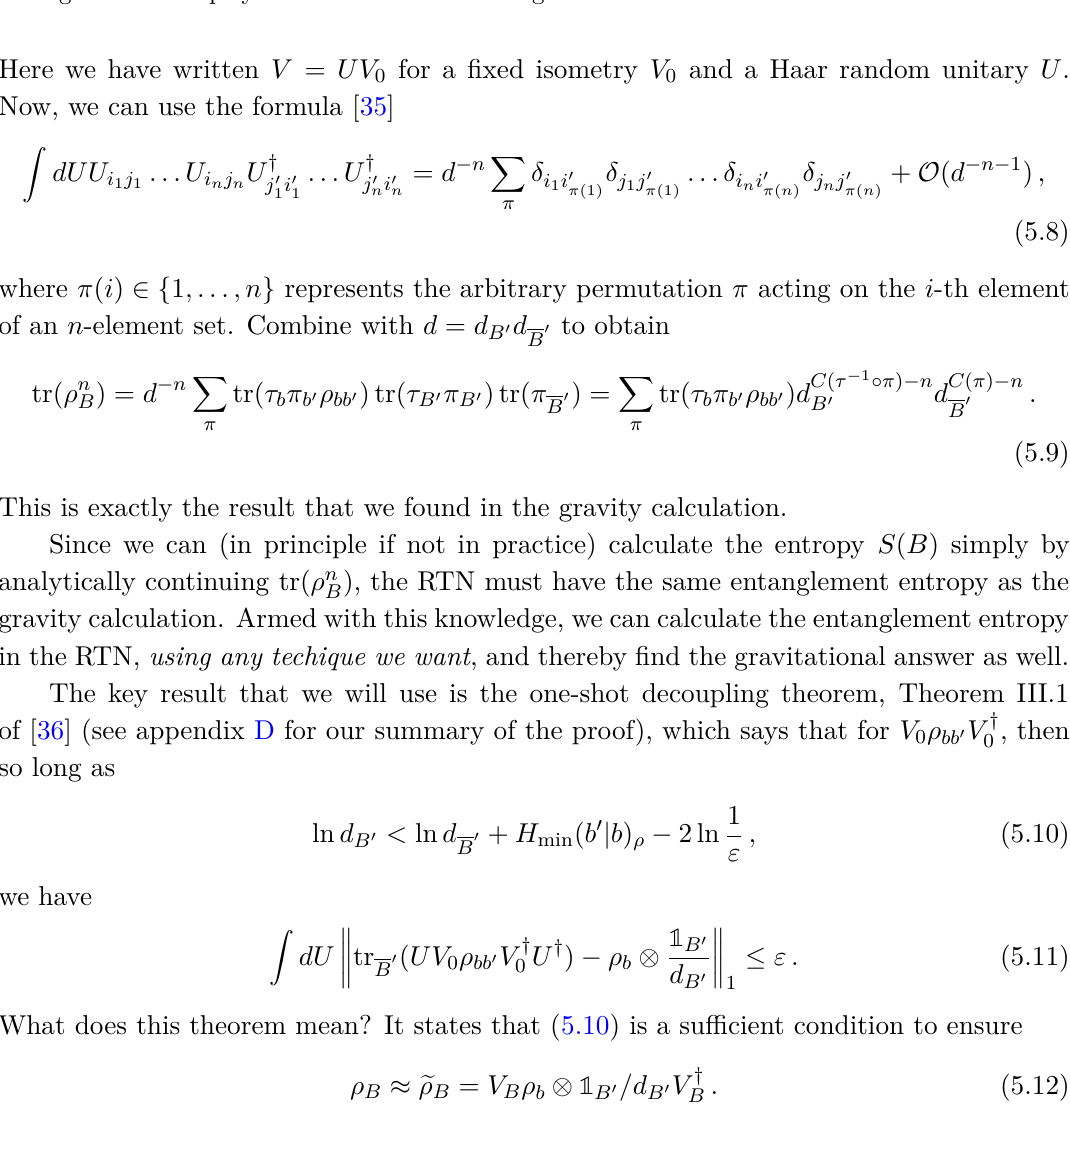
Figure 6 . Simple random tensor network analogous to figure 1 with fixed areas. The “bulk legs” ¯ to “boundary legs” B, B . The (log of the) dimensions of b, b 0 , b are related by isometries V, V B , V B the legs B 0 and B 0 play the role of the areas in figure